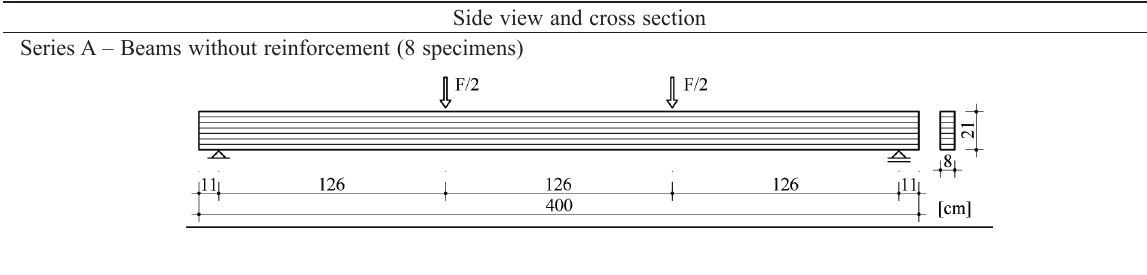
Side view and cross